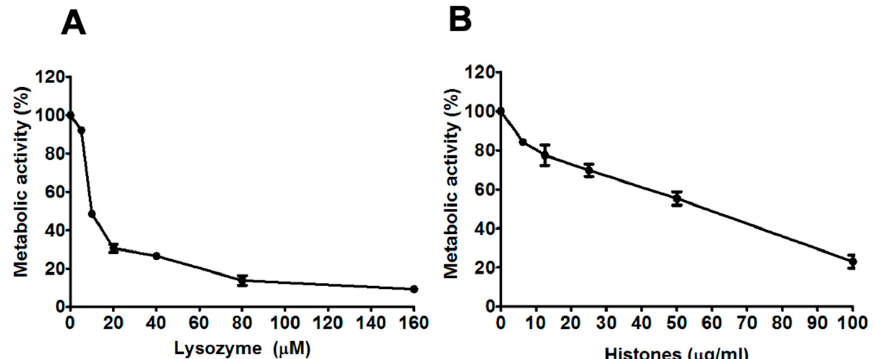
Figure 1. Concentration-dependent antifungal activity of lysozyme and histones against A. fumigatus V130-15 ( A ) Metabolic activity after 2 h incubation with lysozyme (5–160 µM). ( B ) Metabolic activity after 2 h incubation with histones (6.25–100 µg/mL). In each experiment, hyphae were grown overnight in RPMI and the media was refreshed prior to adding the lysozyme or histones in phosphate buffered saline. Metabolic activity was determined by XTT assay. Data was obtained in two independent experiments, each with triplicate readings; mean values ± SD are shown. J. Fungi 2020 , 6 , x FOR PEER REVIEW